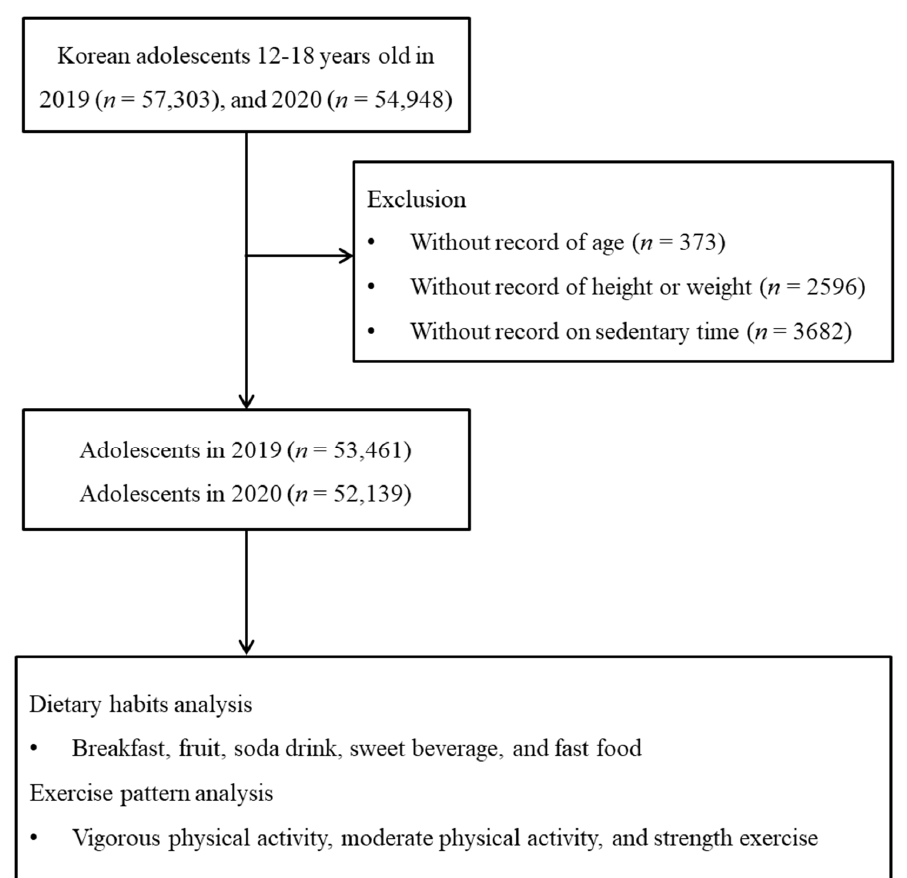
Figure 1. F lowchart of the major steps involved in the conduction of this